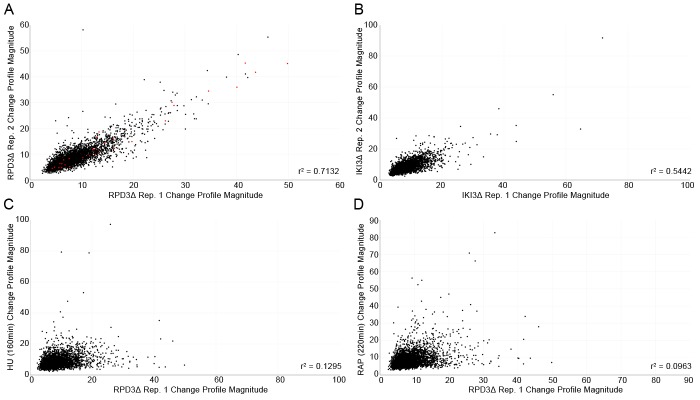
Quality control scatterplots comparing the protein localization change profile magnitudes for each protein (calculated using the sum of squares over the features of the profile) between replicates of the same perturbation, and between different perturbations.(A) Comparison of the two replicates of the rpd3Δ perturbation. (B) Comparison of the two replicates of the iki3Δ perturbation. (C) Comparison of one replicate of the rpd3Δ perturbation with 160 min of hydroxyurea treatment, and (D) comparison of one replicate of the rpd3Δ perturbation with 220 min of rapamycin treatment. The squared correlation coefficient for each scatterplot is shown in the bottom right corner. Proteins that have localization changes previously detected by Chong et al. (2015) for the rpd3Δ perturbation are shown as red points in (A).